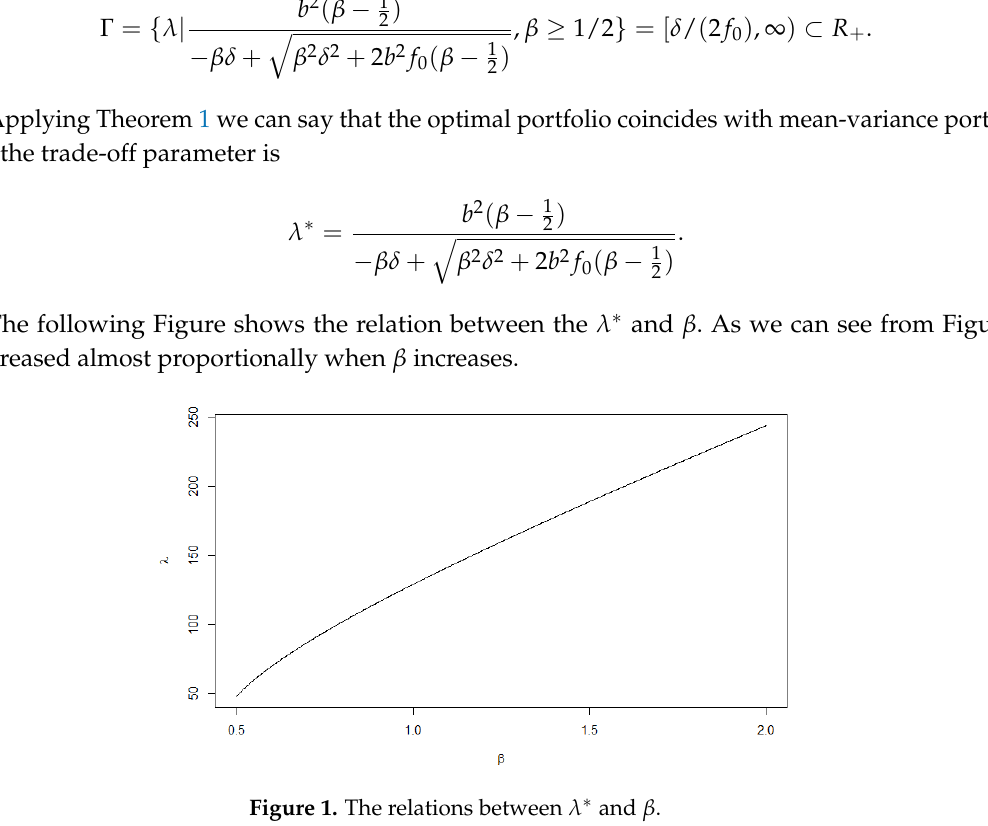
Figure 1. The relations between λ ∗ and β